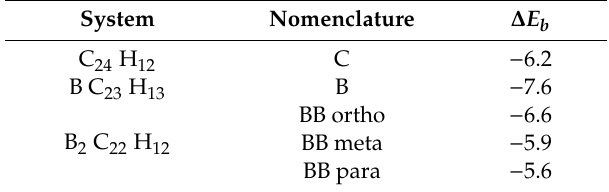
Table 3. Binding energy ( ∆ E b in kJ / mol H 2 ) of adsorbed H 2 in coronene and boron–doped models. The nomenclature introduced here will be used for shorthand notation of the systems